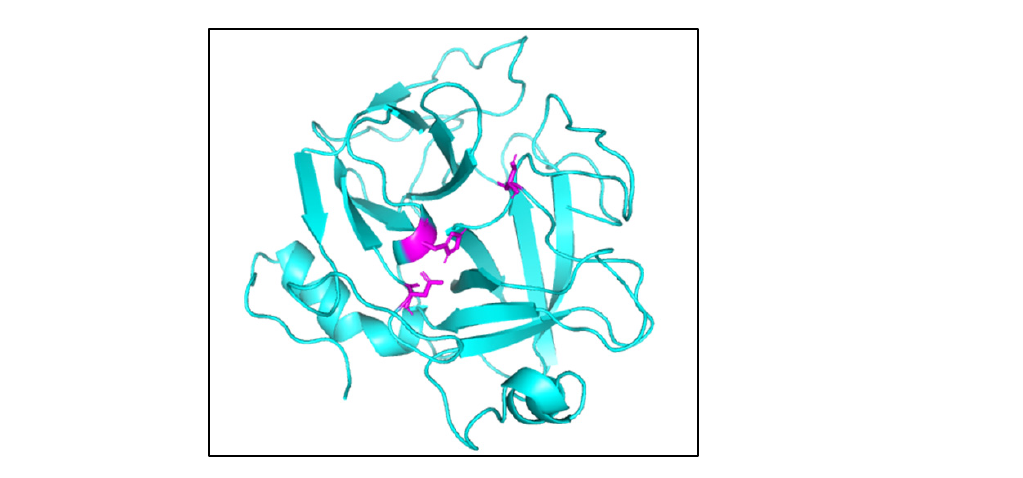
Figure 9. The theoretical model of Cdtsp-2 generated by PyMol. The amino acid residues referring to the active site are represented in purple.